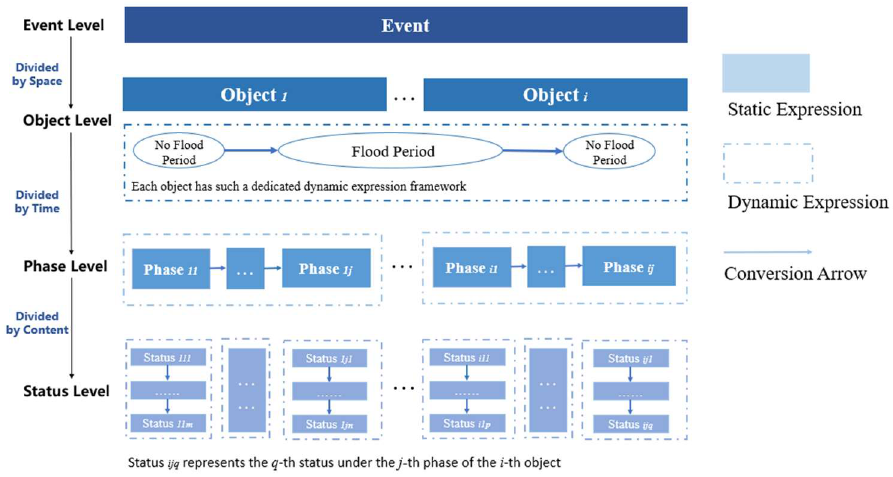
Figure 1. Schematic diagram of EMMPFO.